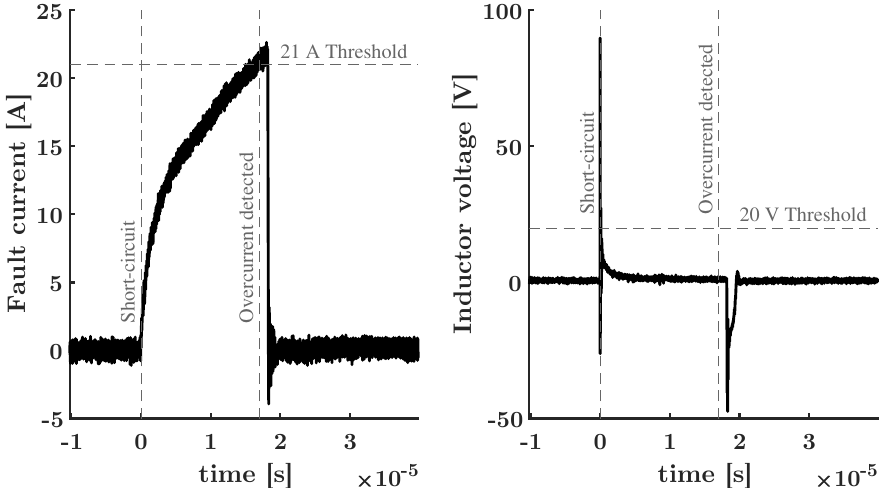
Figure 8. Experimental results when the SSCB is short-circuited with a high fault resistance resulting in the overcurrent detection being triggered when the current exceeds 21 A.